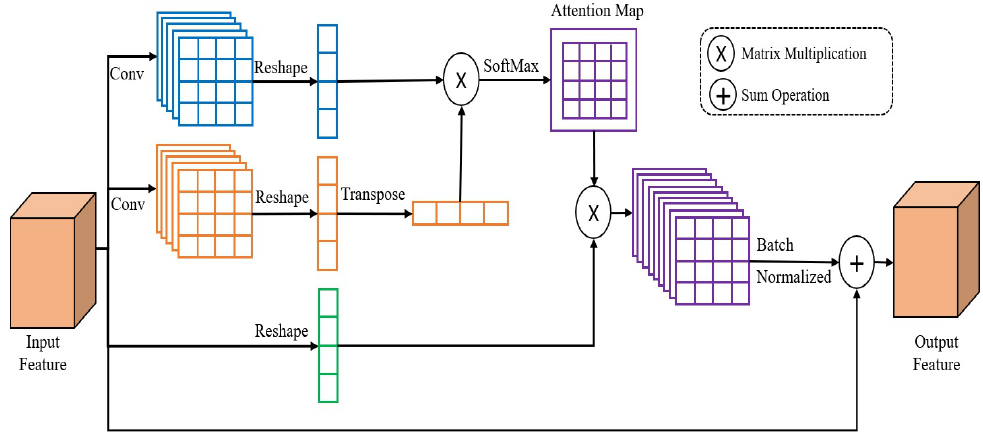
Figure 3. PAM attention module.